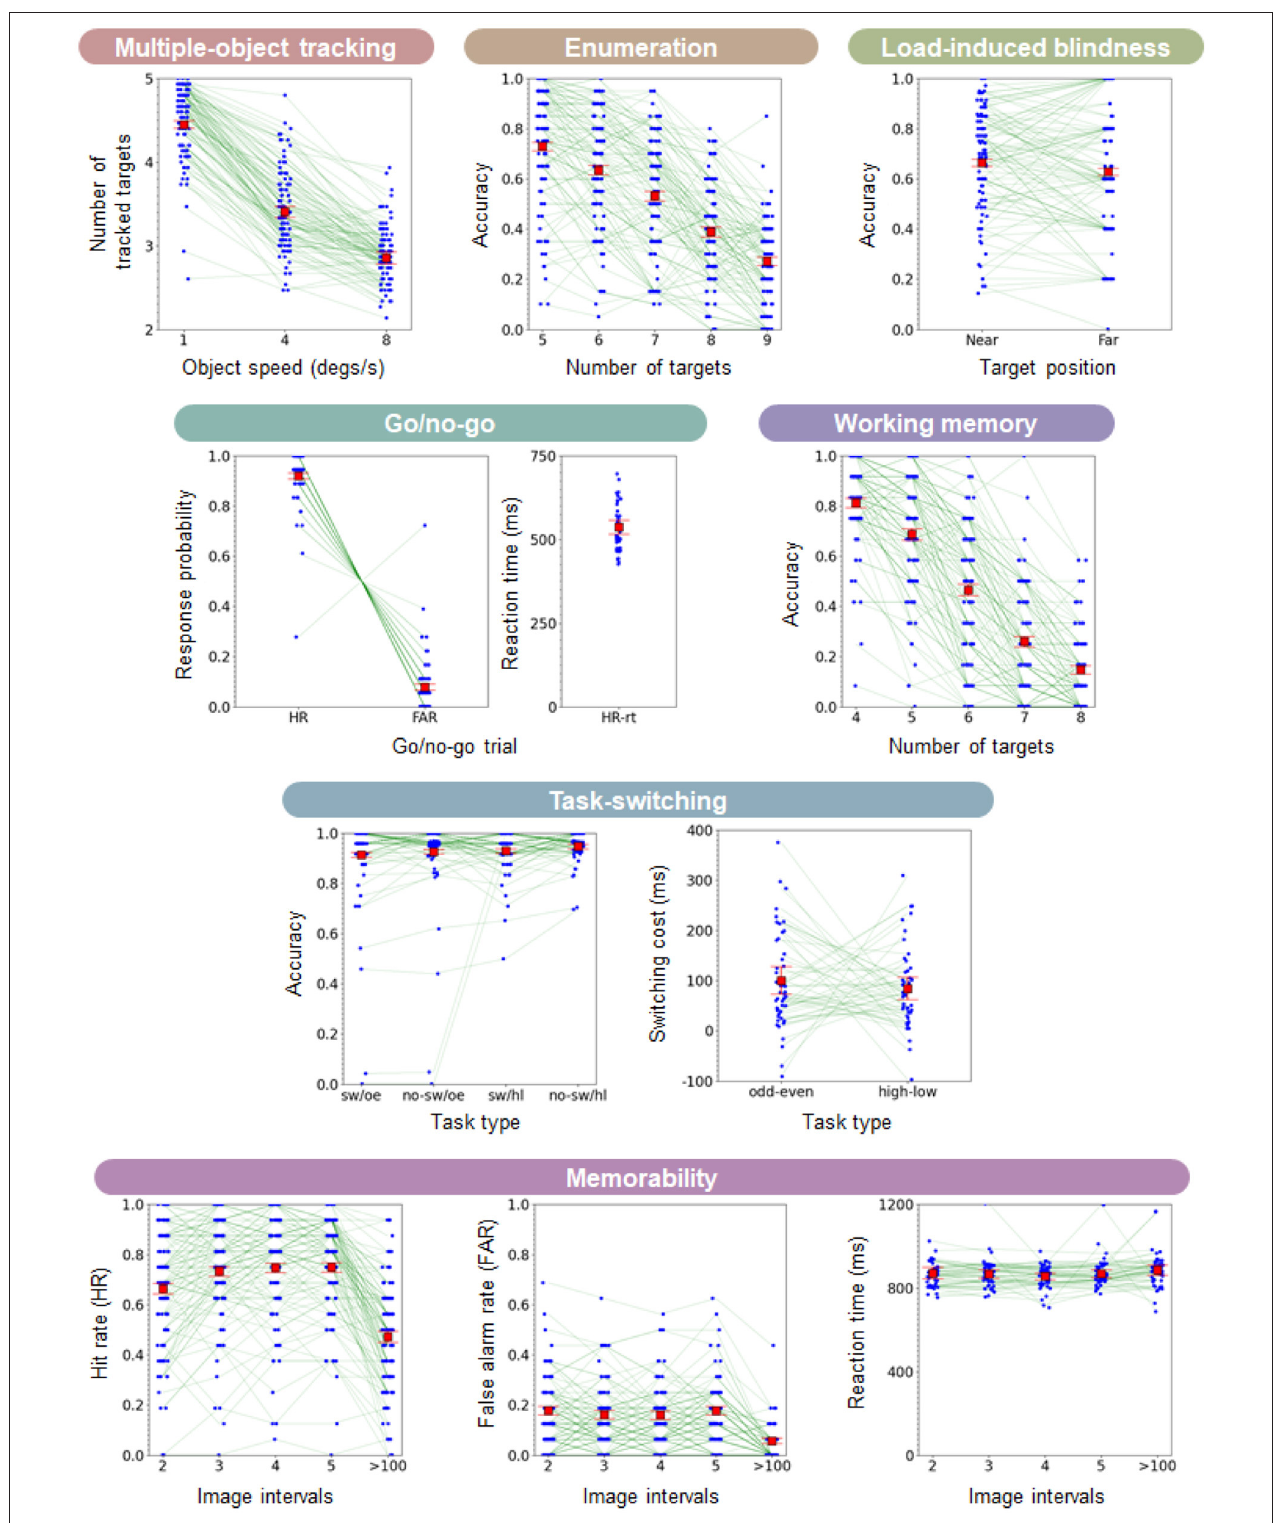
FIGURE 5 | Results of all tasks. The response probability or reaction time is shown for each task. The horizontal axis of each panel indicates the stimulus conditions. The small blue circle depicts the individual performance. The thin green line connects each individual performance across different stimulus parameters. The red square and error bars show the mean probability and 95% credible intervals calculated from Bayesian statistical